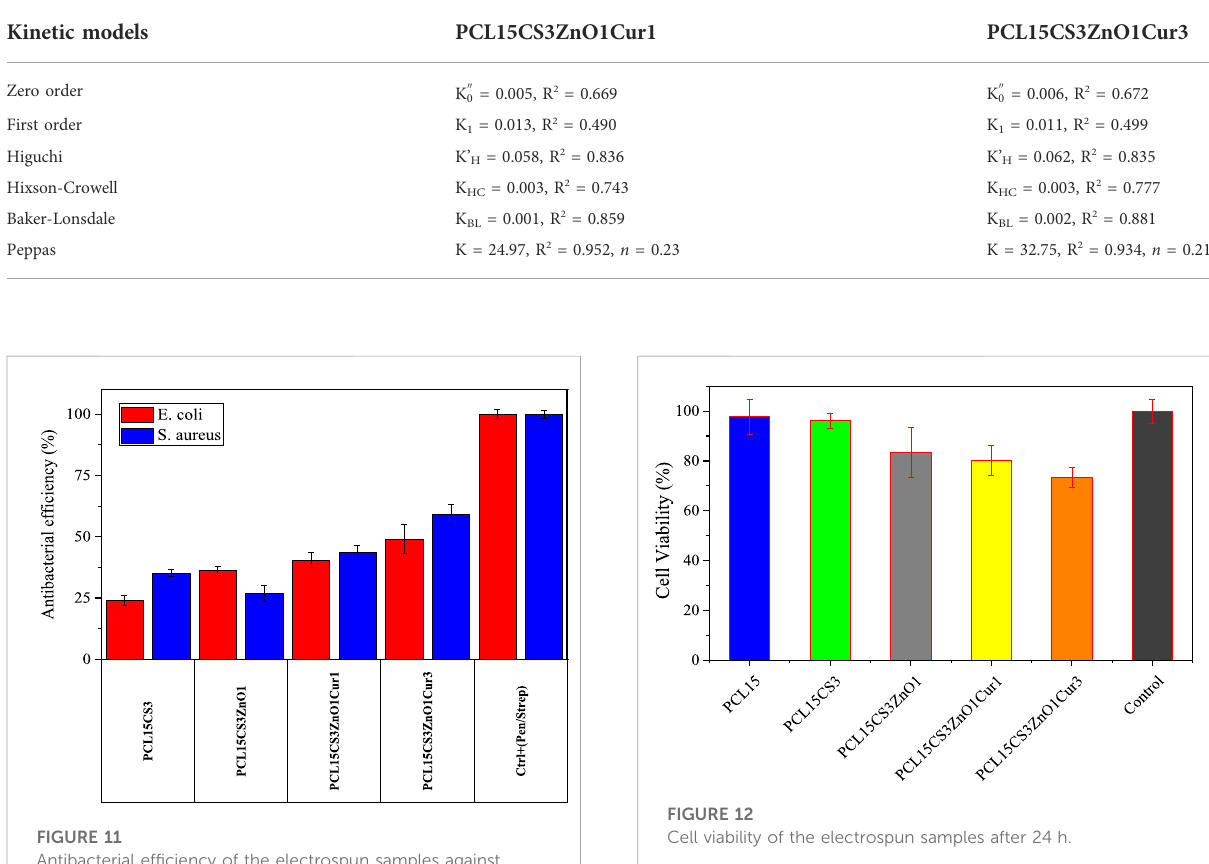
TABLE 5 Parameters of different kinetic models for the release pro fi le of Cur-containing electrospun samples.